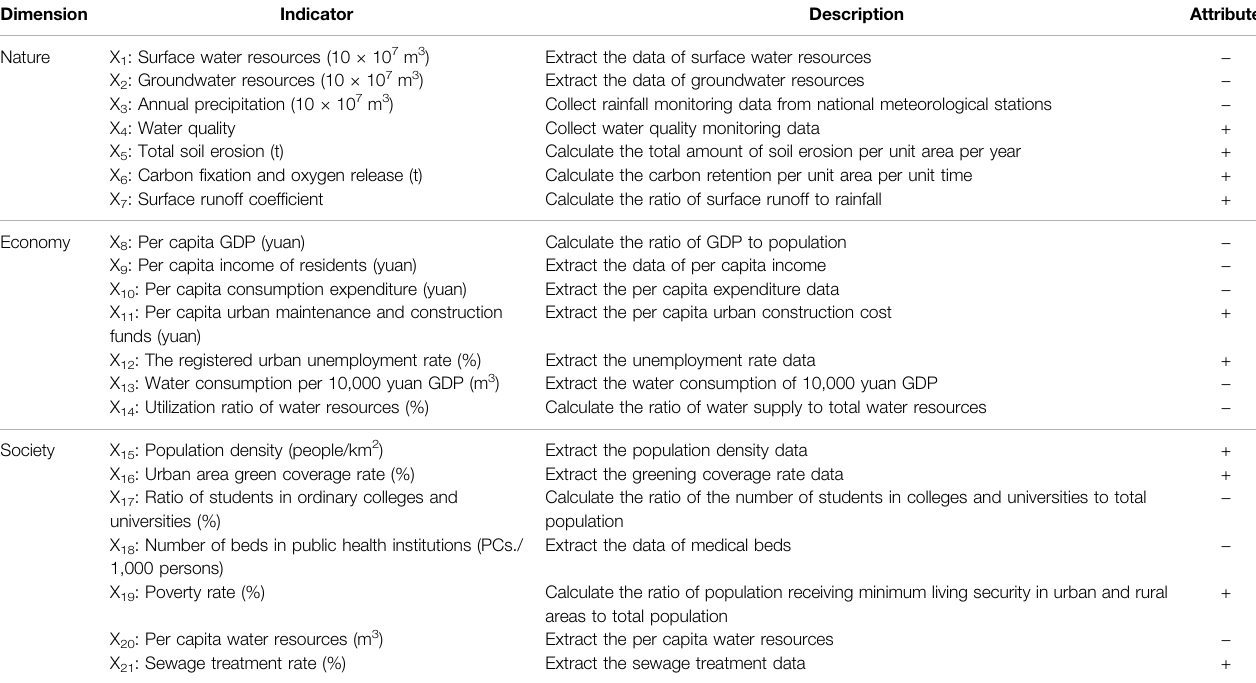
TABLE 1 | Evaluation index system of water resources value. Dimension Indicator Description Attribute